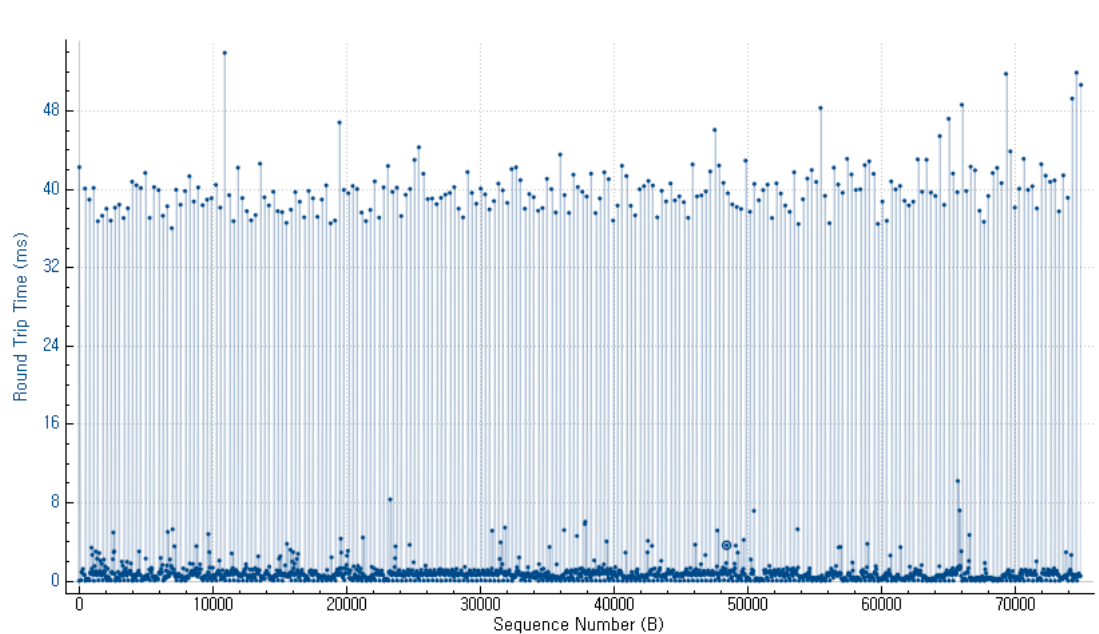
Figure 15. Round-trip time (IEC 61850: IEC 61850 client module—KEMA IED Simulator).